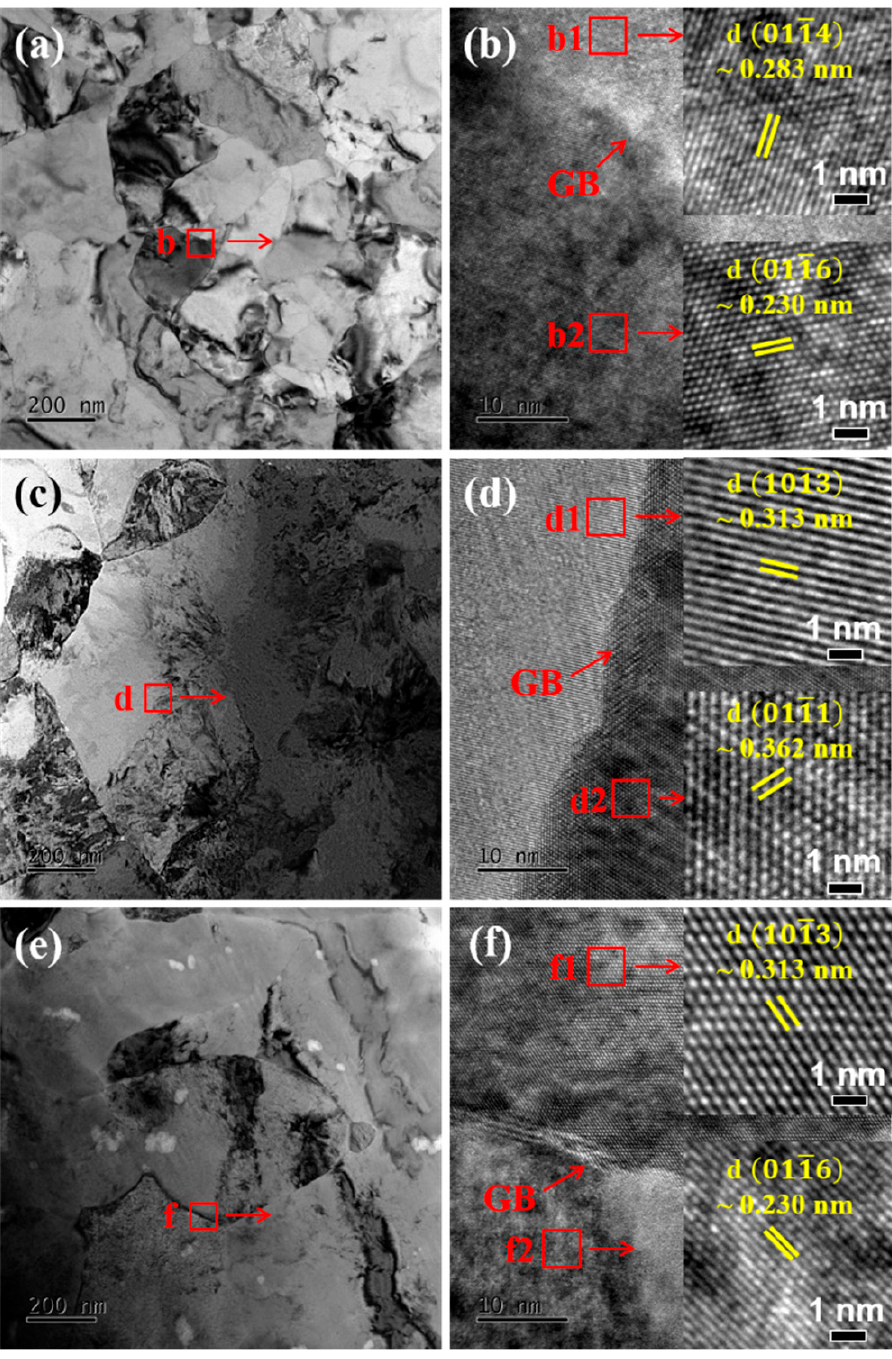
Figure 4. TEM bright-field (TEM-BF) images and high-resolution phase contrast (HRTEM) images near grain boundaries (GBs) of Sb 2 Te thin films annealed at different temperatures: ( a , b ) 140 °C; ( c , d ) 200 °C; ( e , f ) 400 °C. The insets are the inverse fast Fourier transform (IFFT) images of the lattices on both sides of the grain boundaries.